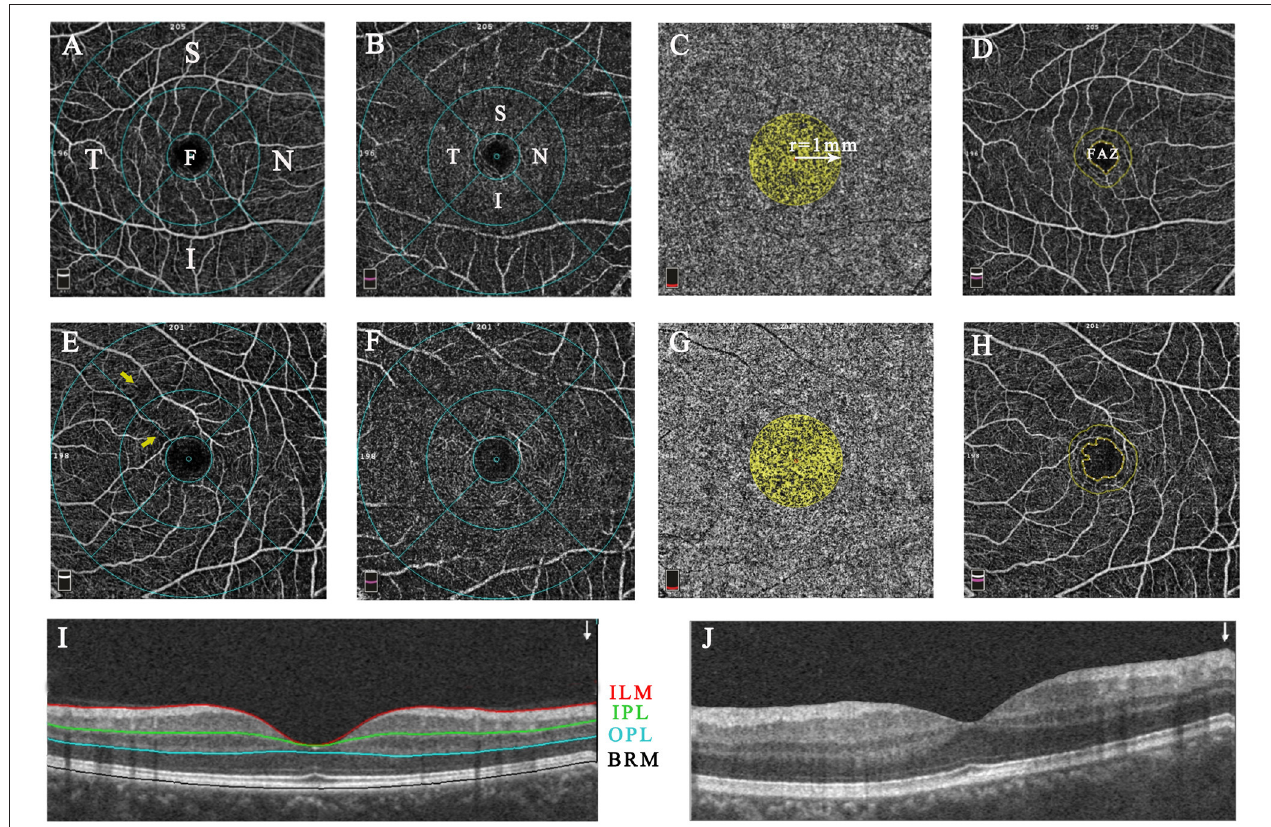
FIGURE 1 | The representative macular image diagram of layer and sector segmentation and vascular parameter measurements in healthy (A–D,I) and Behcet’s uveitis subjects (E–H,J). The images were acquired within a 6.0 × 6.0-mm macular cube scan centered on the fovea in 4 default en-face slabs: the SCP (ILM to IPL; A,E ), the DCP (IPL to OPL; B,F ), the CC (BRM to BRM + 30 µ m; C,G ), and the retina slab (ILM to OPL; D,H ). B-scan image shows the place of segmentation (I,J). The SCP and DCP layers were overlaid by the ETDRS grid comprised of 3 concentric rings of 1, 3, and 6-mm diameter; The fovea, parafovea, and perifovea were defined as the inner circle, medial annulus, and outer annulus, respectively. The vascular density was automatically measured in different subfields of SCP and DCP (A,B,E,F). The CC flow area was calculated within a 1-mm radius circle centered at the fovea (C,G) . The FAZ area and perimeter were quantified basing on the retina slab, and automated FAZ boundary detection was performed by the AngioVue software (D,H) . Capillary arcade disruptions with rarefaction of vessels (yellow arrow) were present in the temporal and superior sectors of the BU patient. F, fovea; S, superior; T, temporal; I, inferior; N, nasal; SCP, superficial capillary plexus; ILM, inner limiting membrane; IPL, inner plexiform layer; OPL, outer plexiform layer; CC, choriocapillaris; BRM, Bruch’s membrane; DCP, deep capillary plexus; ETDRS, the Early Treatment Diabetic Retinopathy Study; FAZ, foveal avascular